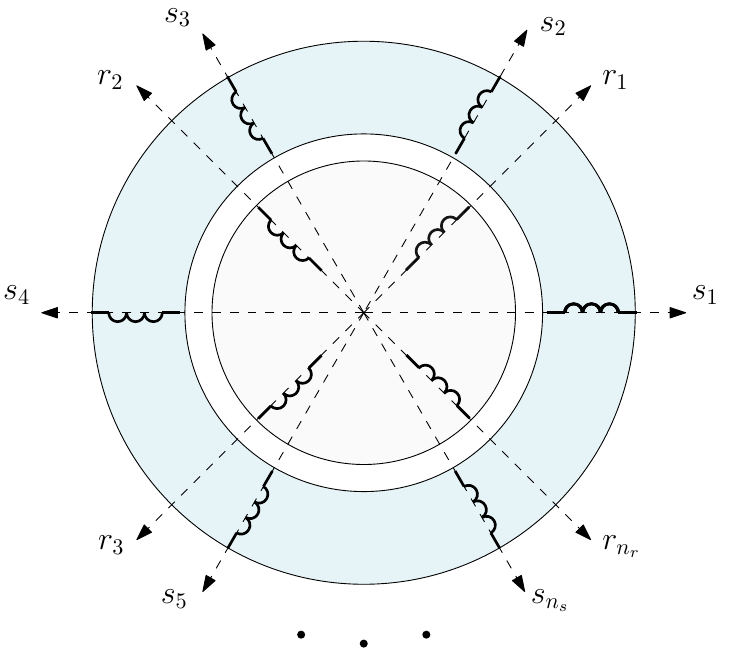
Figure 1. Reference frame of the IM with the axes of all stator windings ( s 1 , s 2 , . . . , s n connected to the stator iron and conductors and those of the rotor windings ( r 1 , r 2 , . . . , r n connected to the rotor iron and